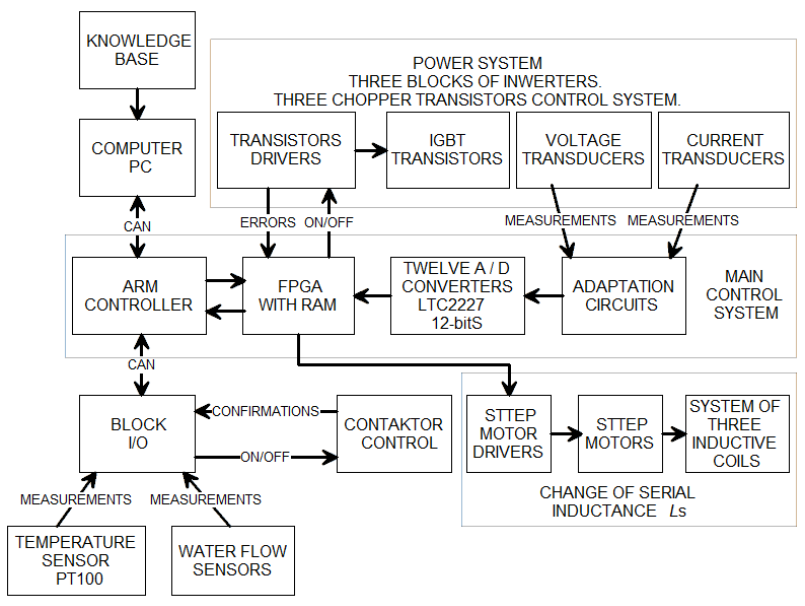
Figure 11. Schematic diagram of the generator control distributed